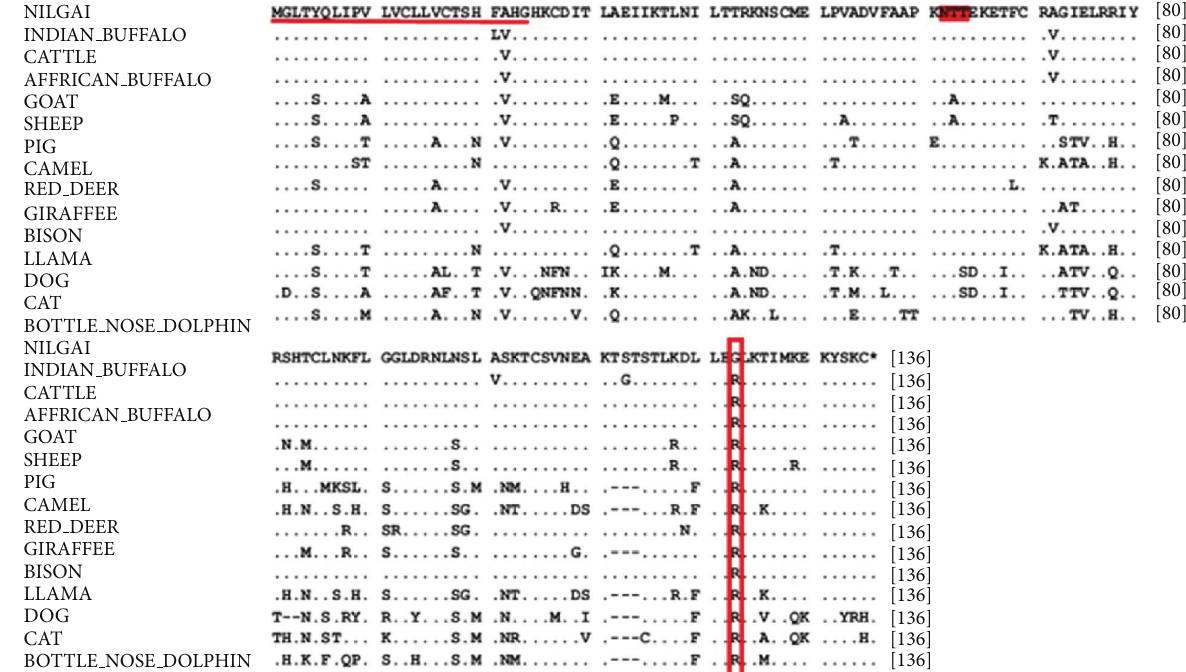
Figure 2: Alignment of predicted amino acid sequence of nilgai IL4 with different species. Identity to the nilgai sequence is indicated by a dot and differences by the corresponding one-letter symbol of the amino acid. Gaps introduced for optimal alignment are indicated by dashes. The conserved leader sequence is underlined; N-glycosylation site is highlighted. One amino acid present in nilgai but replaced in all others is marked with a rectangle.